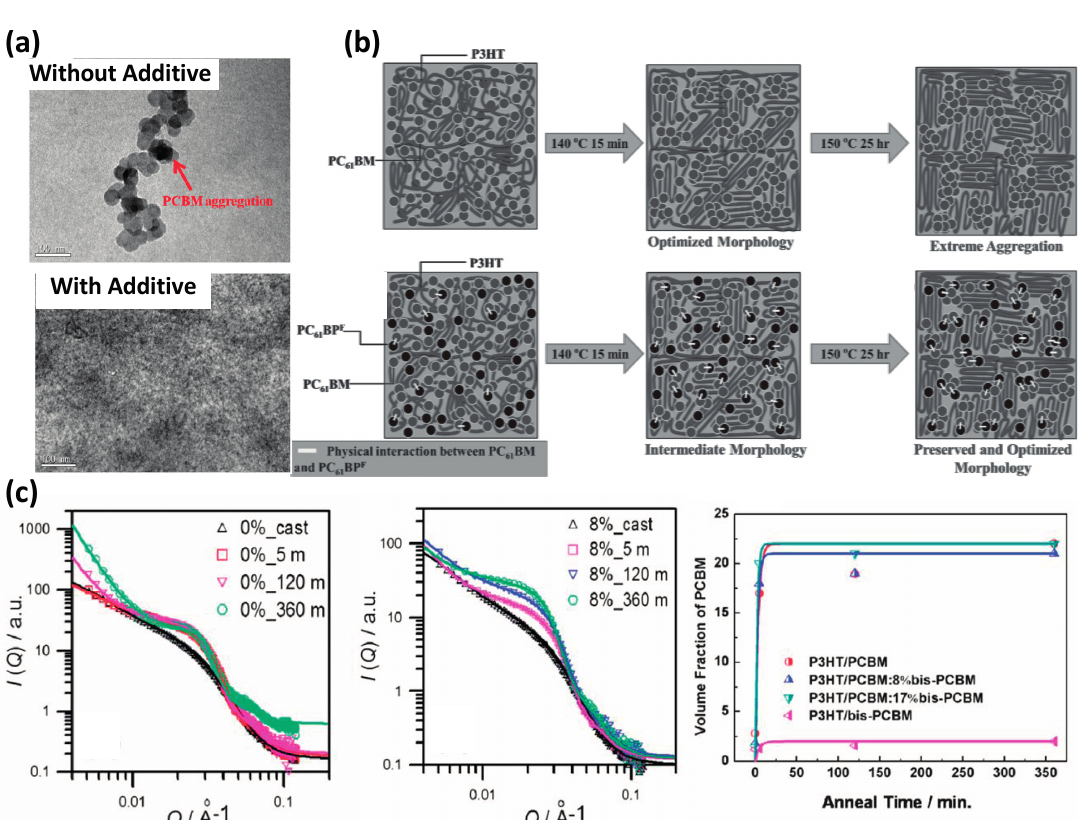
Figure 7. ( a ) TEM images of P3HT/PCBM blends without and with additive